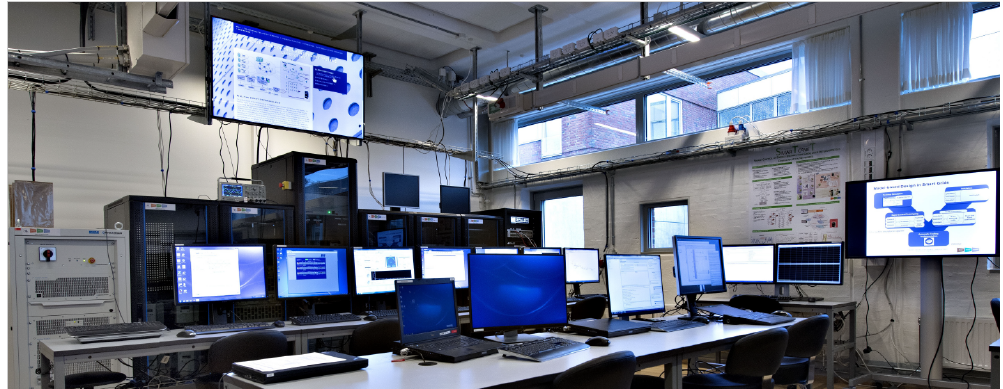
Figure 5. The various subsystems and workstations involved in the RT-HIL setup available in SES Lab at the Department of Energy Technology, Aalborg University, Denmark